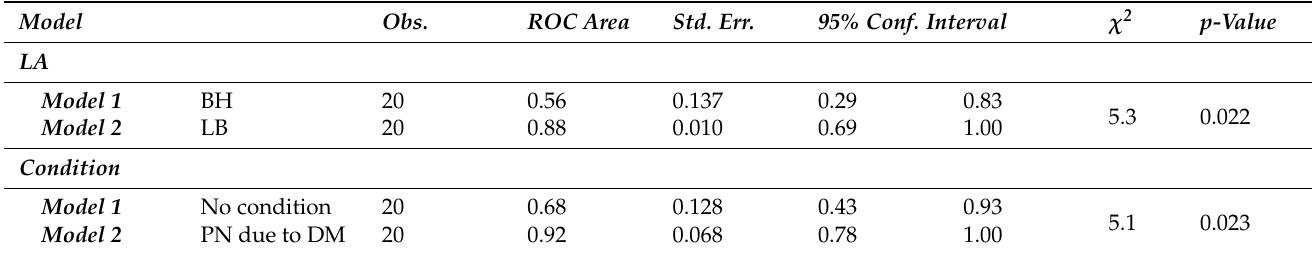
Table 2. Differences between model predictions based on the duration pattern of different types of local anesthetics and different animal model conditions.